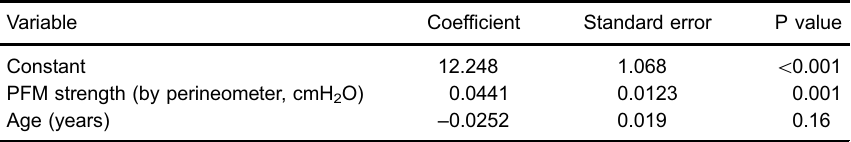
Table 3. Model for oxygen consumption at ventilatory anaerobic threshold (VO 2 VAT) prediction from pelvic fl oor muscles (PFM) strength and age.